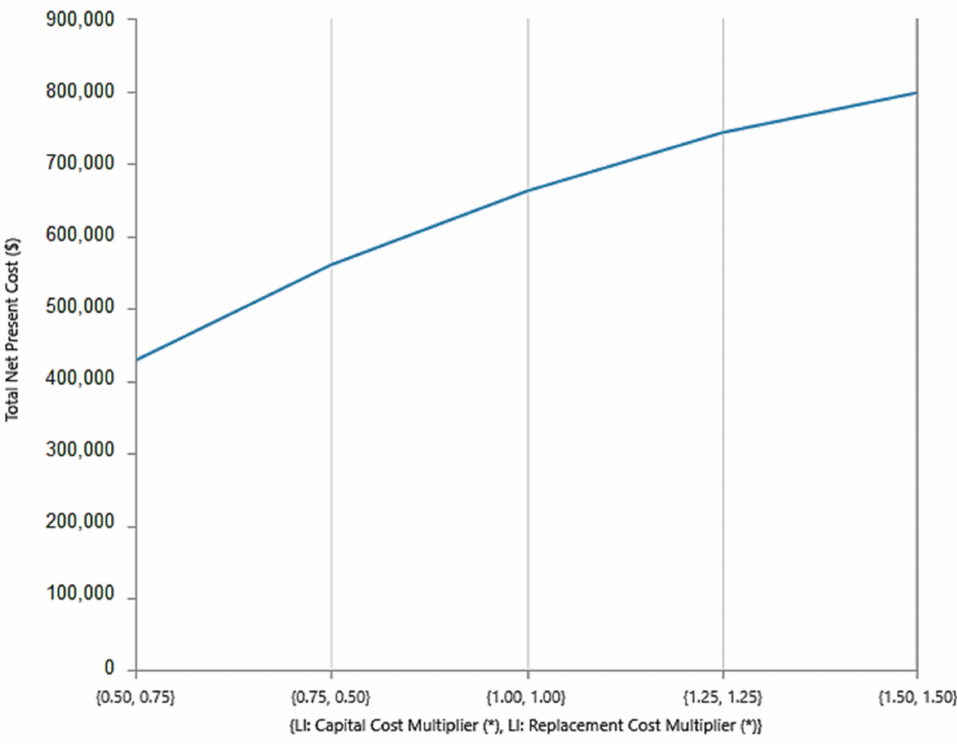
Figure 14. Effect of Lithium-Ion Cost on TNPC of the proposed